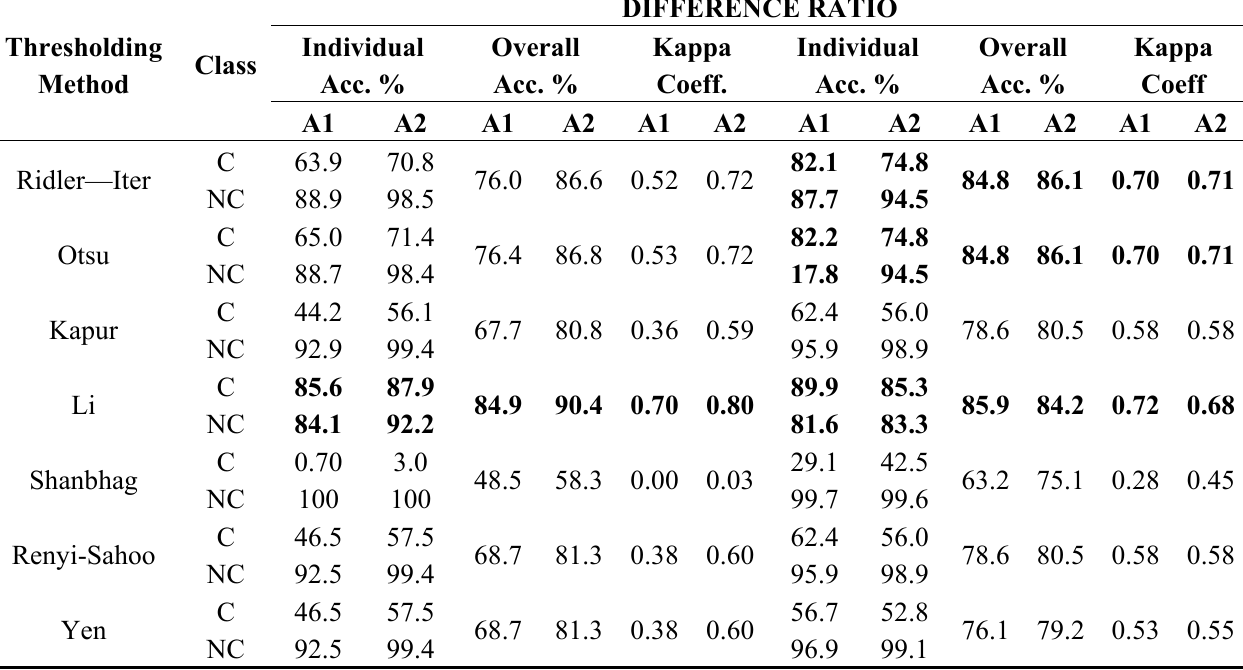
Table 2. Individual and global accuracies obtained for the thresholded indices corresponding to level 2, areas A1 & A2.